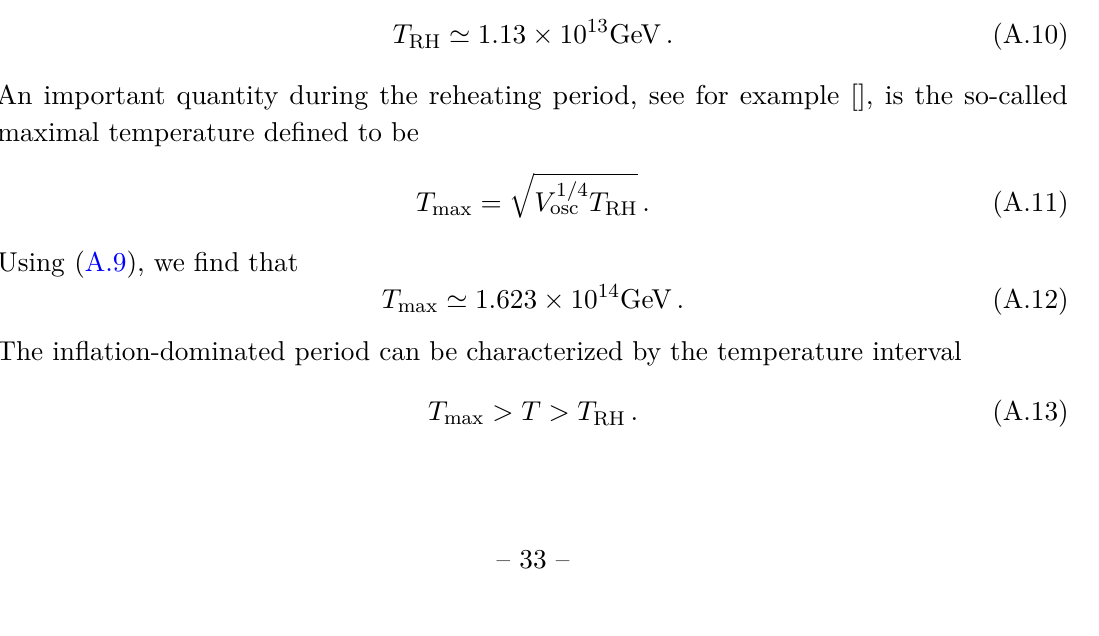
Figure 5. The numerical solutions for ψ ( t ) and H ( t ) , where we have set κ − 1 and t 9 . 89 × 10 6 mark the beginning and end of the inflationary period. The times t > t end ’ correspond to the post inflationary epoch. The time t the potential energy is well approximated by V = 1 beginning of the matter dominated